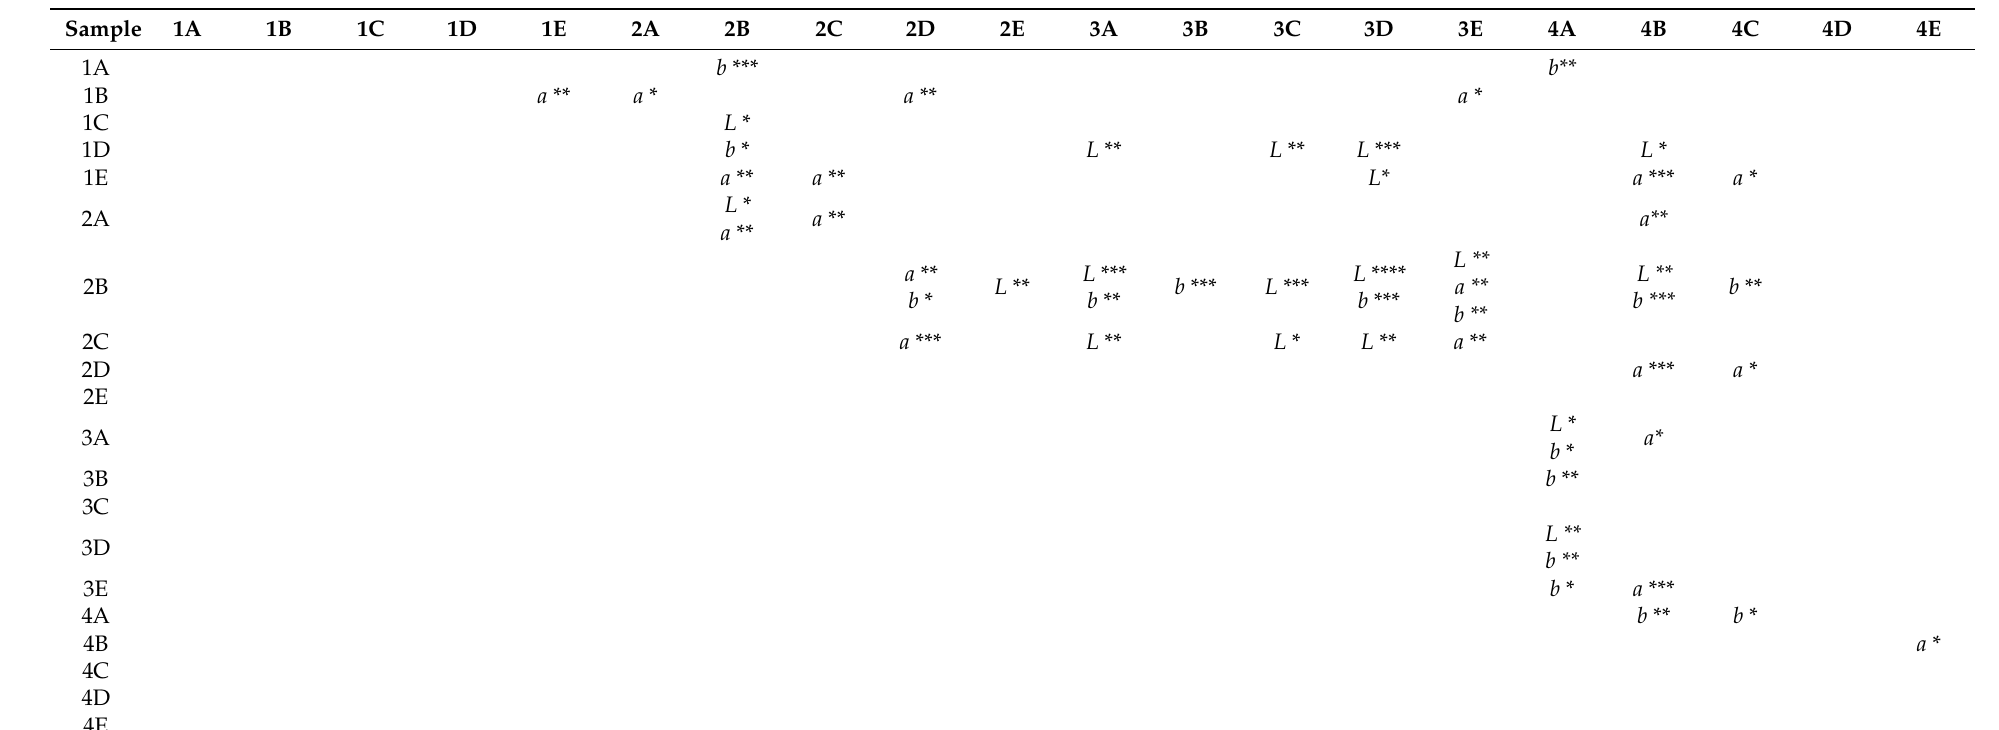
Table 6. Differences among the colorimetric parameters in yellowfin tuna samples from ANOVA and the Tukey